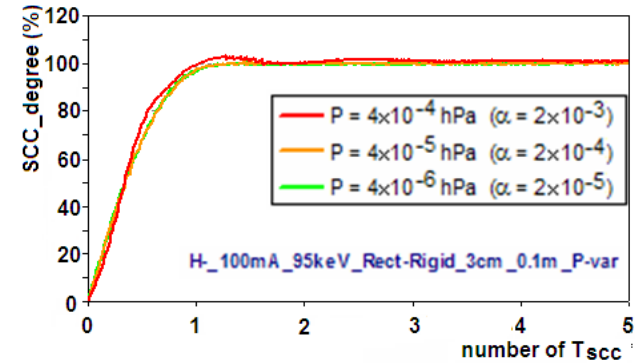
.FIG. 5. (Color) SCCD for several H (cid:1) beam radii.